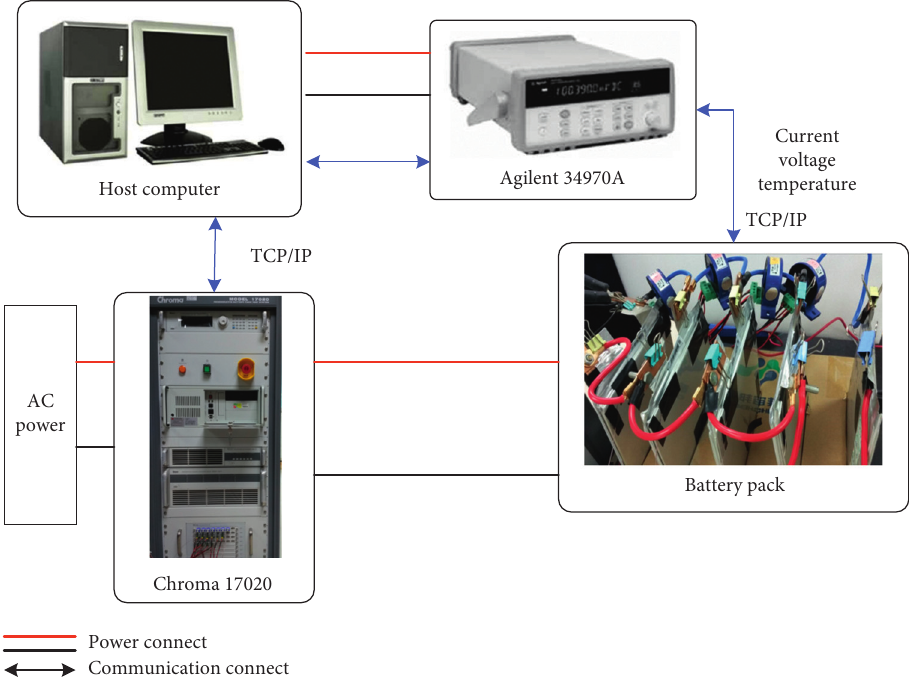
Figure 2: Experimental setup for implementation of the parallel-connected